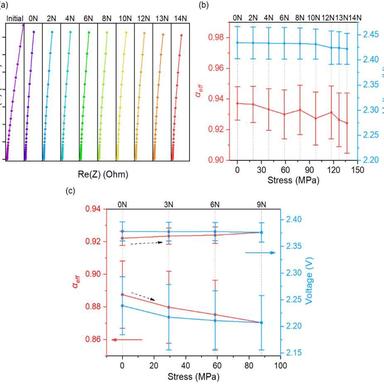
(a) The Nyquist plots of EIS spectra of the unlithiated Al foil sample under different stress conditions, with a scale of 5 × 104 Ohm for axes. (b) The averaged effective CPE exponents αeff and the averaged voltages under different stress conditions. The forces marked on the top correspond to different stress conditions. (c) The averaged effective CPE exponents αeff and the averaged voltages within elastic regime of the Al foil sample. The forces marked on the top correspond to different stress conditions.